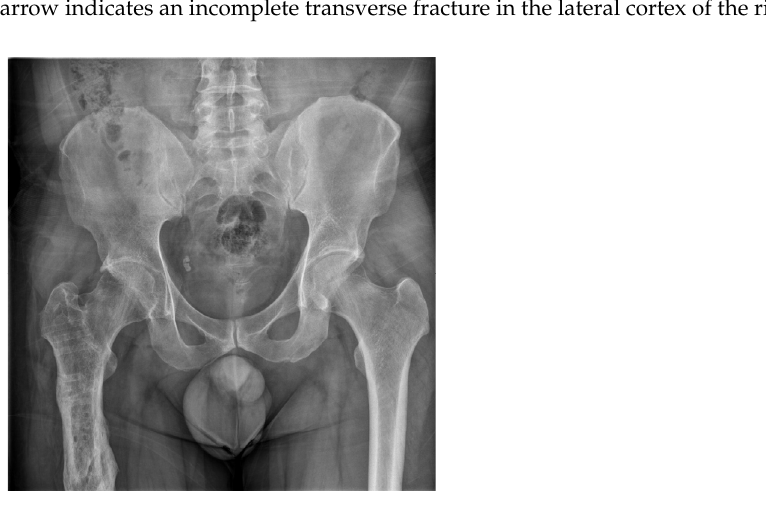
Figure 3. Conventional radiography was performed 6 months after the final operation. The fracture site achieved complete union.